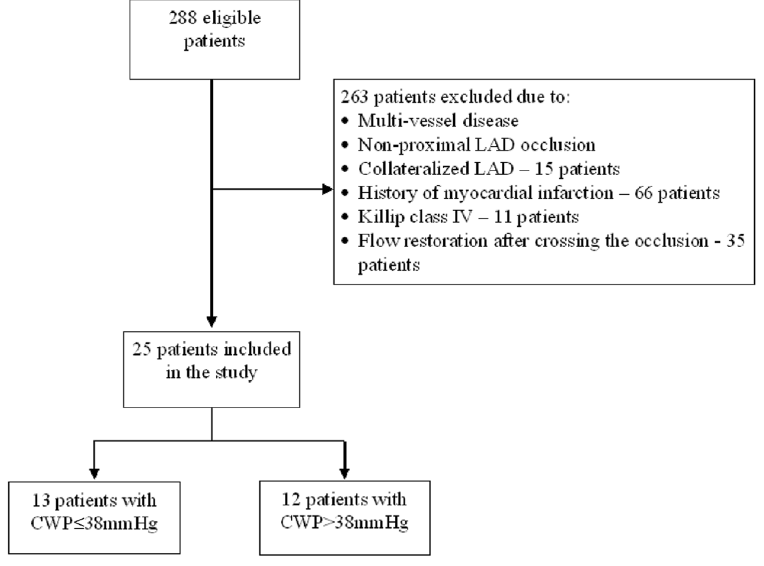
Figure 1. Flowchart. CWP = coronary wedge pressure; LAD = left anterior descending artery.